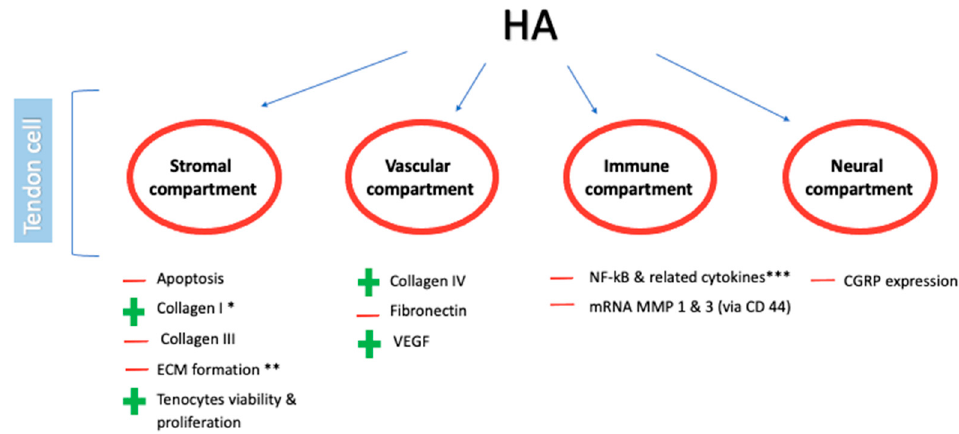
Figure 1. Biological effects modulated by HA (hyaluronic acid) on tendon cells. Note: − and + indicate negative and positive modulation, respectively. * dose-dependent, ** high concentration and HW, *** IL-1 α , IL-6, TNF- α . Abbreviations: ECM (extracellular matrix); VEGF (Vascular-Endothelial Growth Factor); MMP (matrix metalloproteinases); CGRP (Calcitonin Gene Related Peptide); HW (high